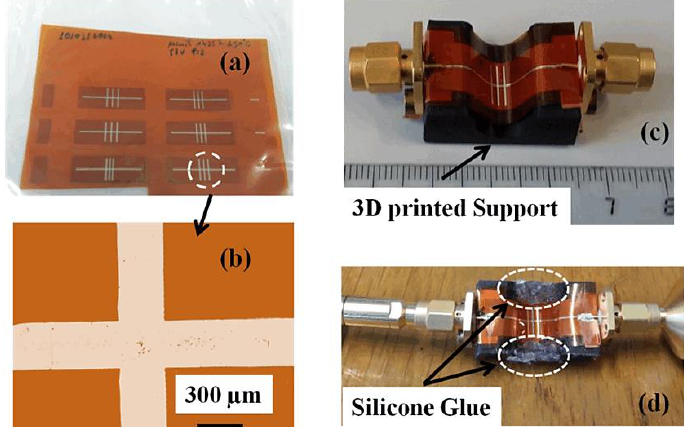
Figure 14. ( a ) Photograph of a set of resonators on Kapton substrate; ( b ) micrograph of a stub loaded along the MS line; ( c ) photograph of the sensor curved on a 3D-printed support; and ( d ) photograph of the sensor under testing [68].